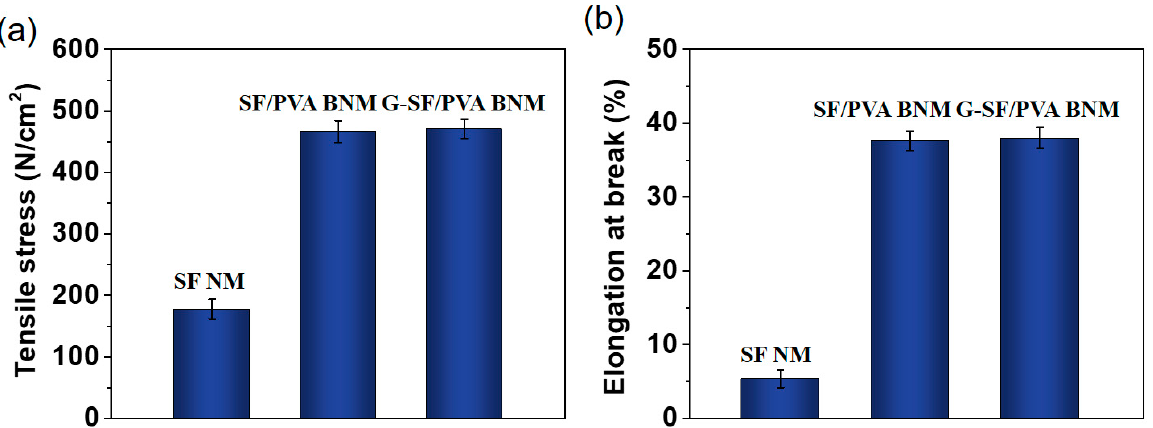
Figure 3. ( a ) The measurements of tensile stress. ( b ) The measurements of elongation at break.